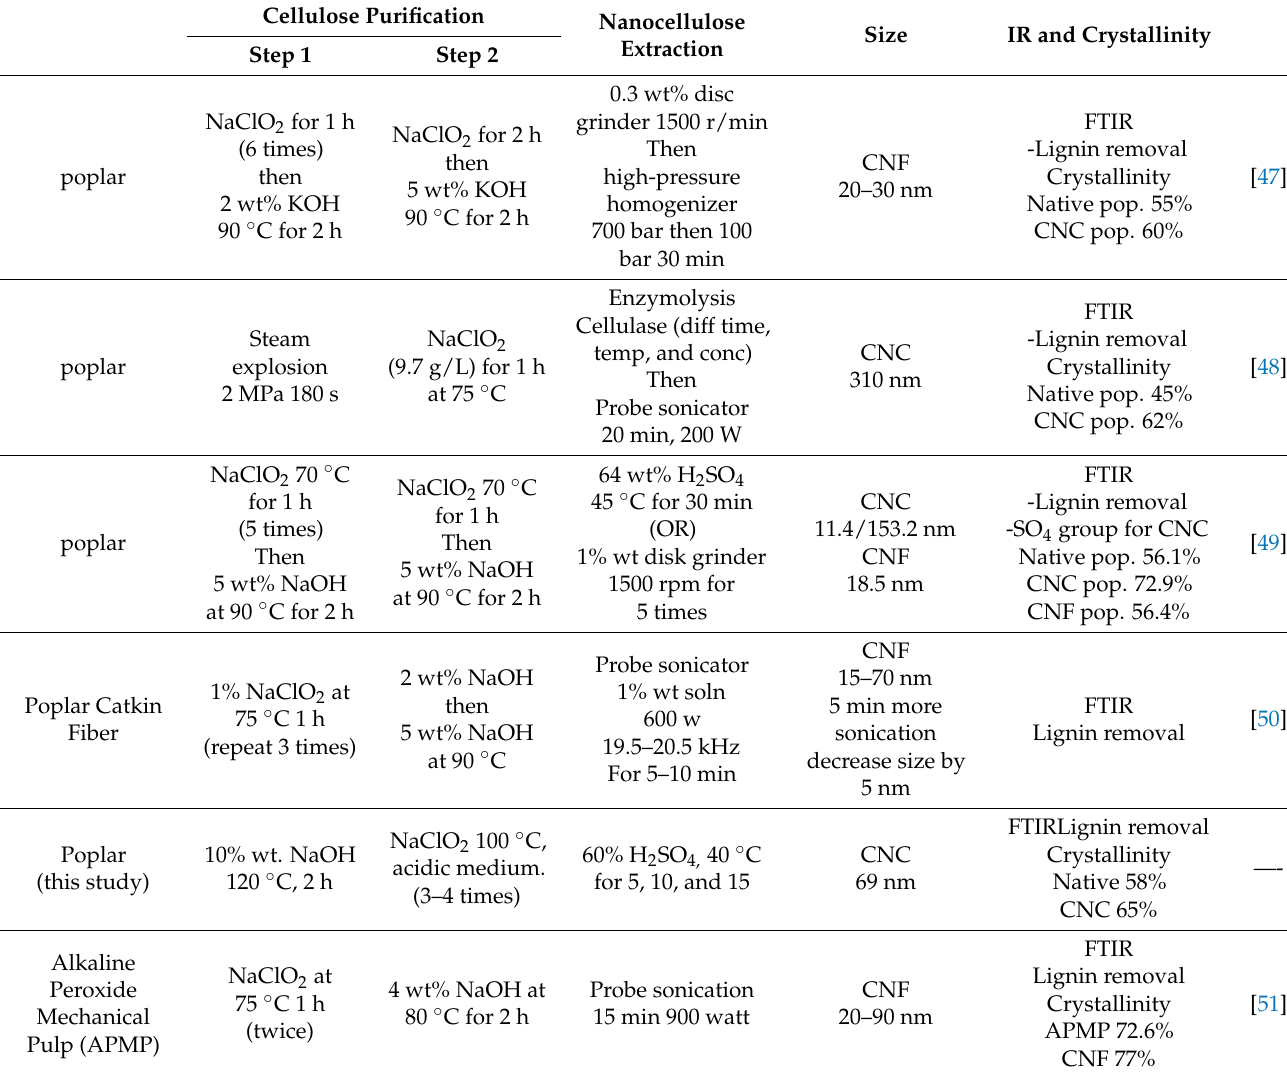
Table 2. Literature published in poplar based nanocellulose; cellulose purification, nanocellulose extraction, and resultant properties are